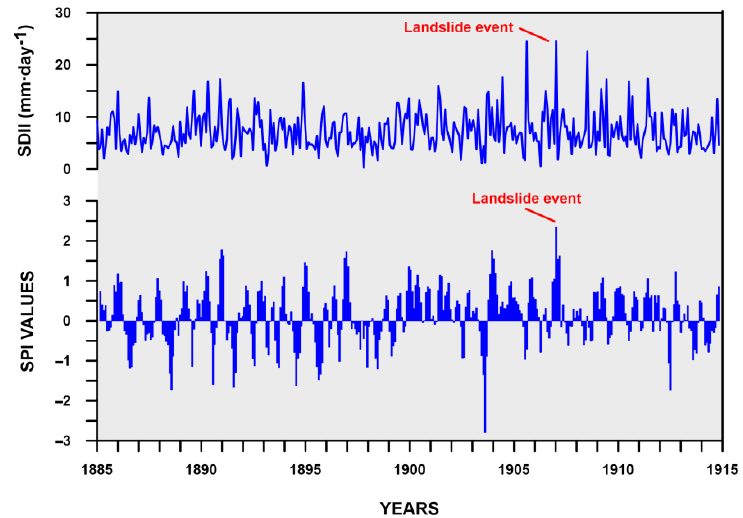
Figure 16. Monthly simple daily intensity index (SDII) vs monthly standardized precipitation index values over 3 months (SPI 3) from 1885 to 1915. The investigated landslide took place at the maximum peak of both the indexes.